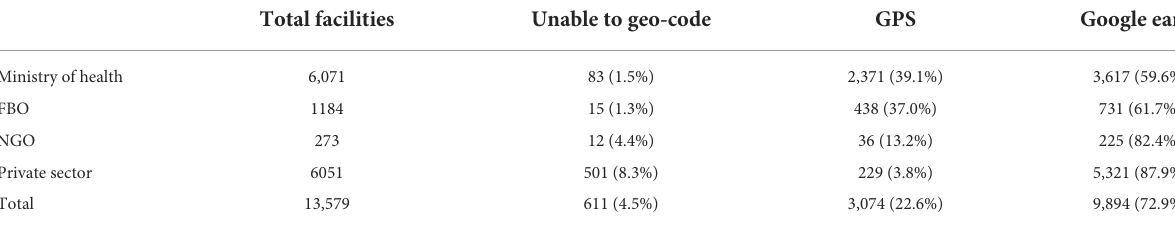
TABLE 2 Geo-coding of health facilities offering curative and preventative services to the general population.